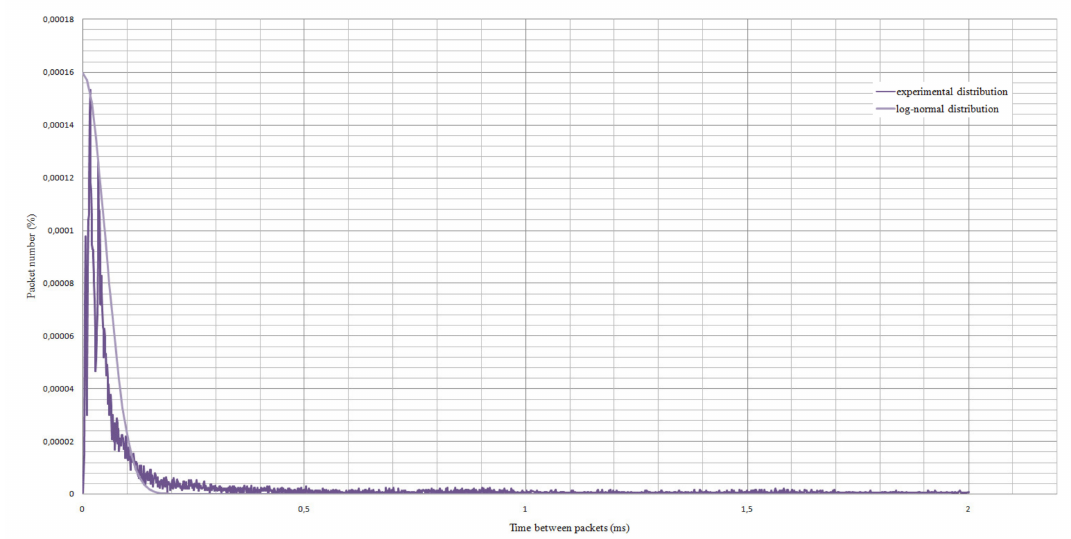
Figure 10. Comparison of the obtained results with the values obtained in the log-normal distribution.